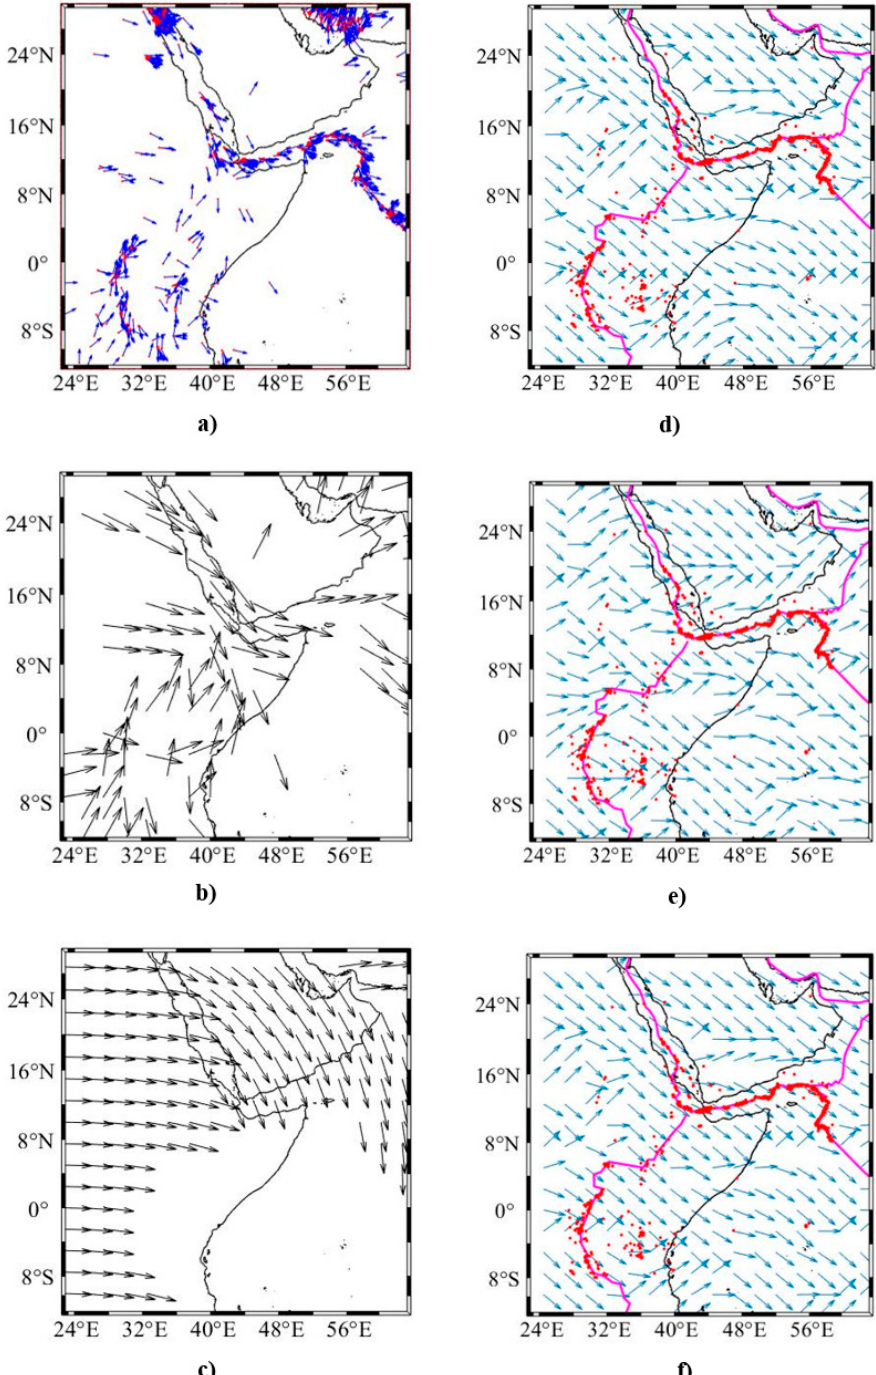
Figure 9. World Stress Map (WSM) 2016: ( a ) input stress data with its direction, ( b ) maximum horizontal shear stress directions, ( c ) direction of plate motion. Estimated maximum shear stress direction at Moho surface from ( d ) horizontal shear stress due to mantle convection [4], ( e ) vertical stress due to mantle plume, and ( f ) horizontal shear and vertical stresses due to mantle convection and plume.